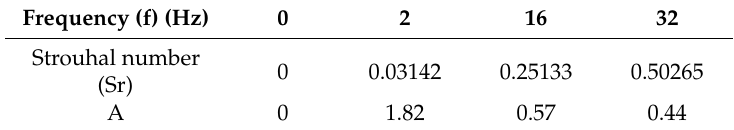
Table 3. The values of A up to 32 Hz in Equation (5) as a function of frequency [7].